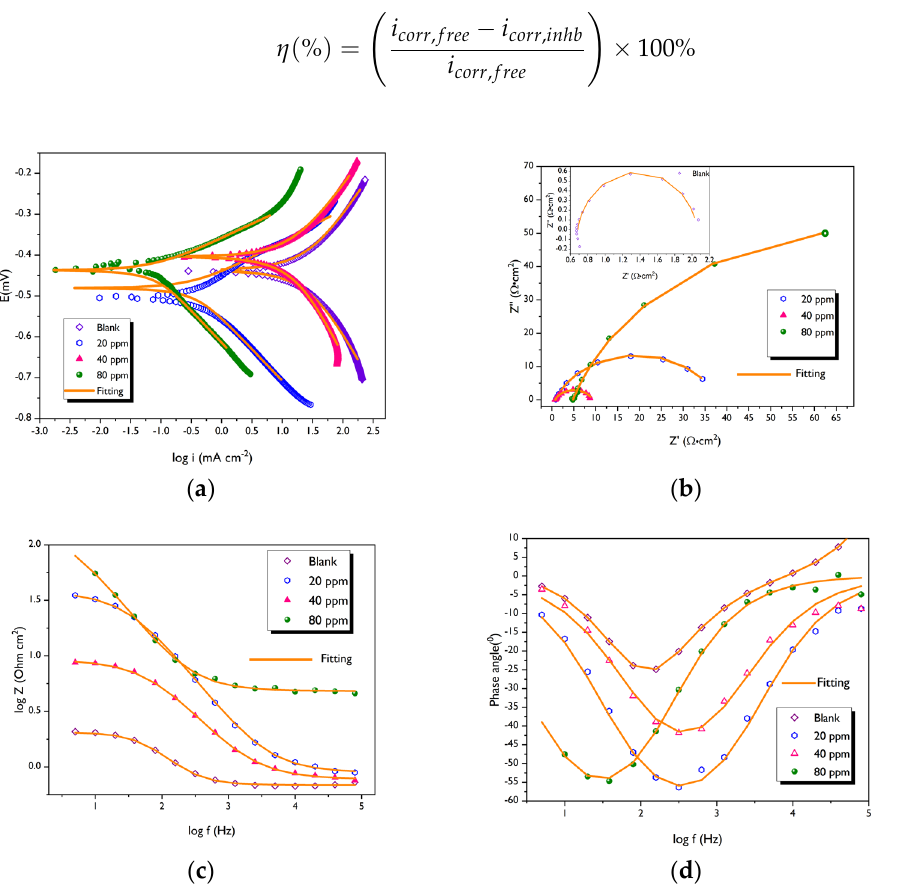
Figure 1. The anti-corrosion behavior of the inhibitor at 323 K. ( a ) Tafel polarization plots; ( b ) Nyquist plot; ( c ) Bode plot; ( d ) Bode phase.